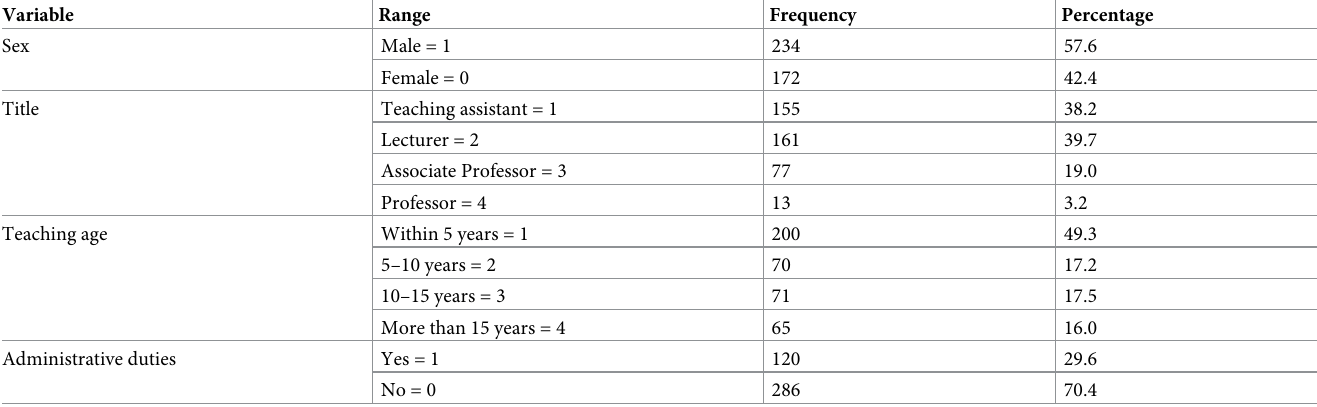
Table 1. Descriptive statistics of sample demographic